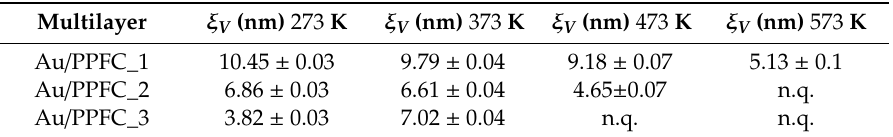
Table 2. Interlayer-particle distance ( ξ V ) calculated from the first order Bragg peak of the multilayers at various temperatures. The errors only given in one row hold for all three MLs with varying temperature. n.q.: not